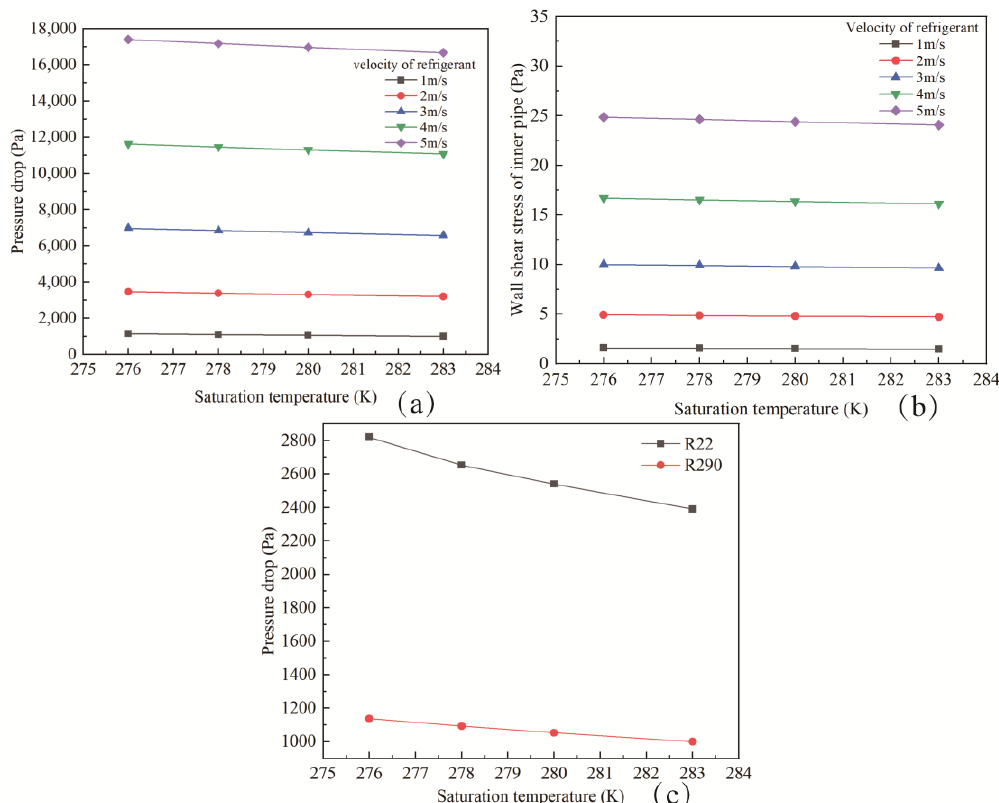
Figure 12. The impact of ( a ) saturation temperature on pressure drop, ( b ) wall shear stress of inner pipe and ( c ) pressure drop of R22 and R290 at different saturation temperatures.